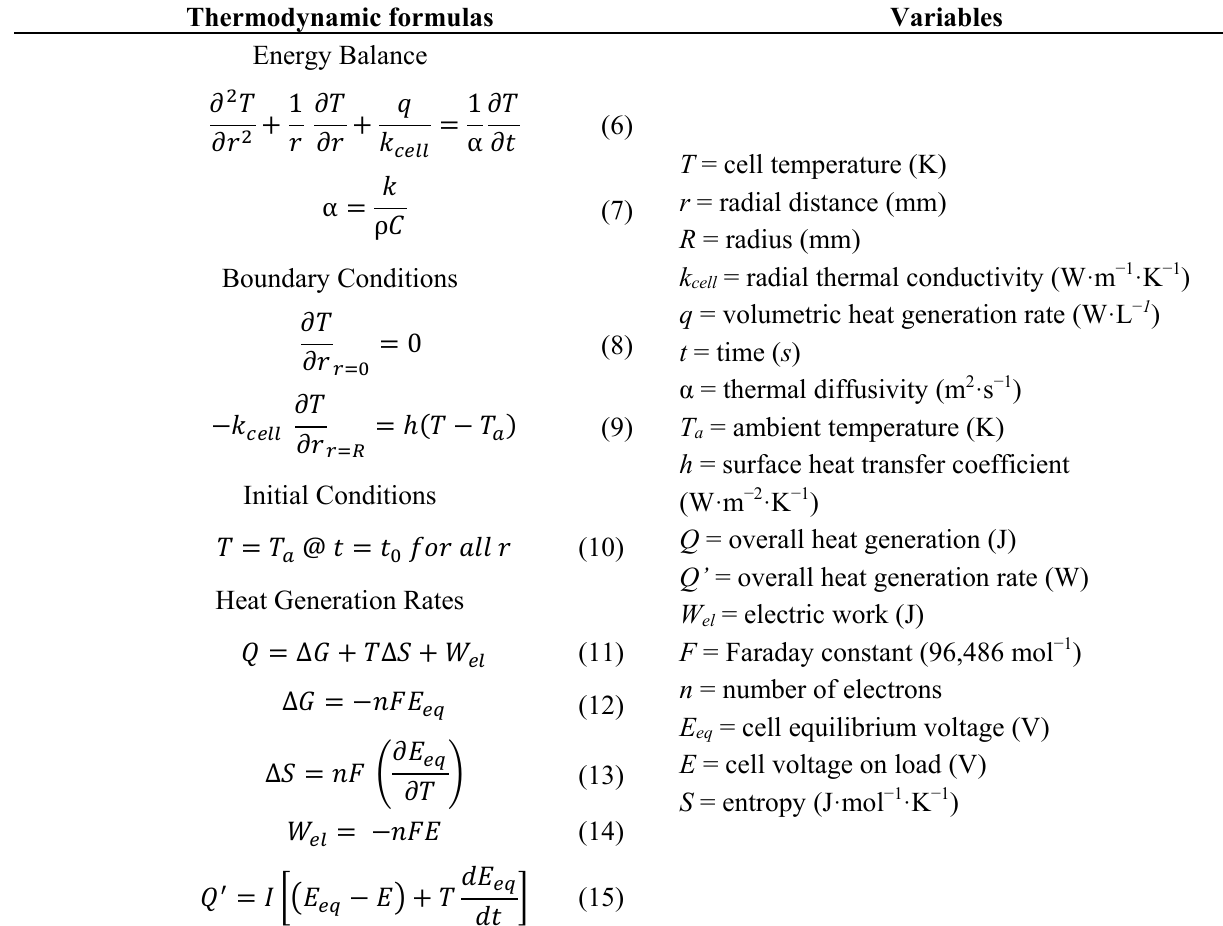
Table 1. Thermodynamic formulas used in the simplified one-dimensional lumped parameters thermal model